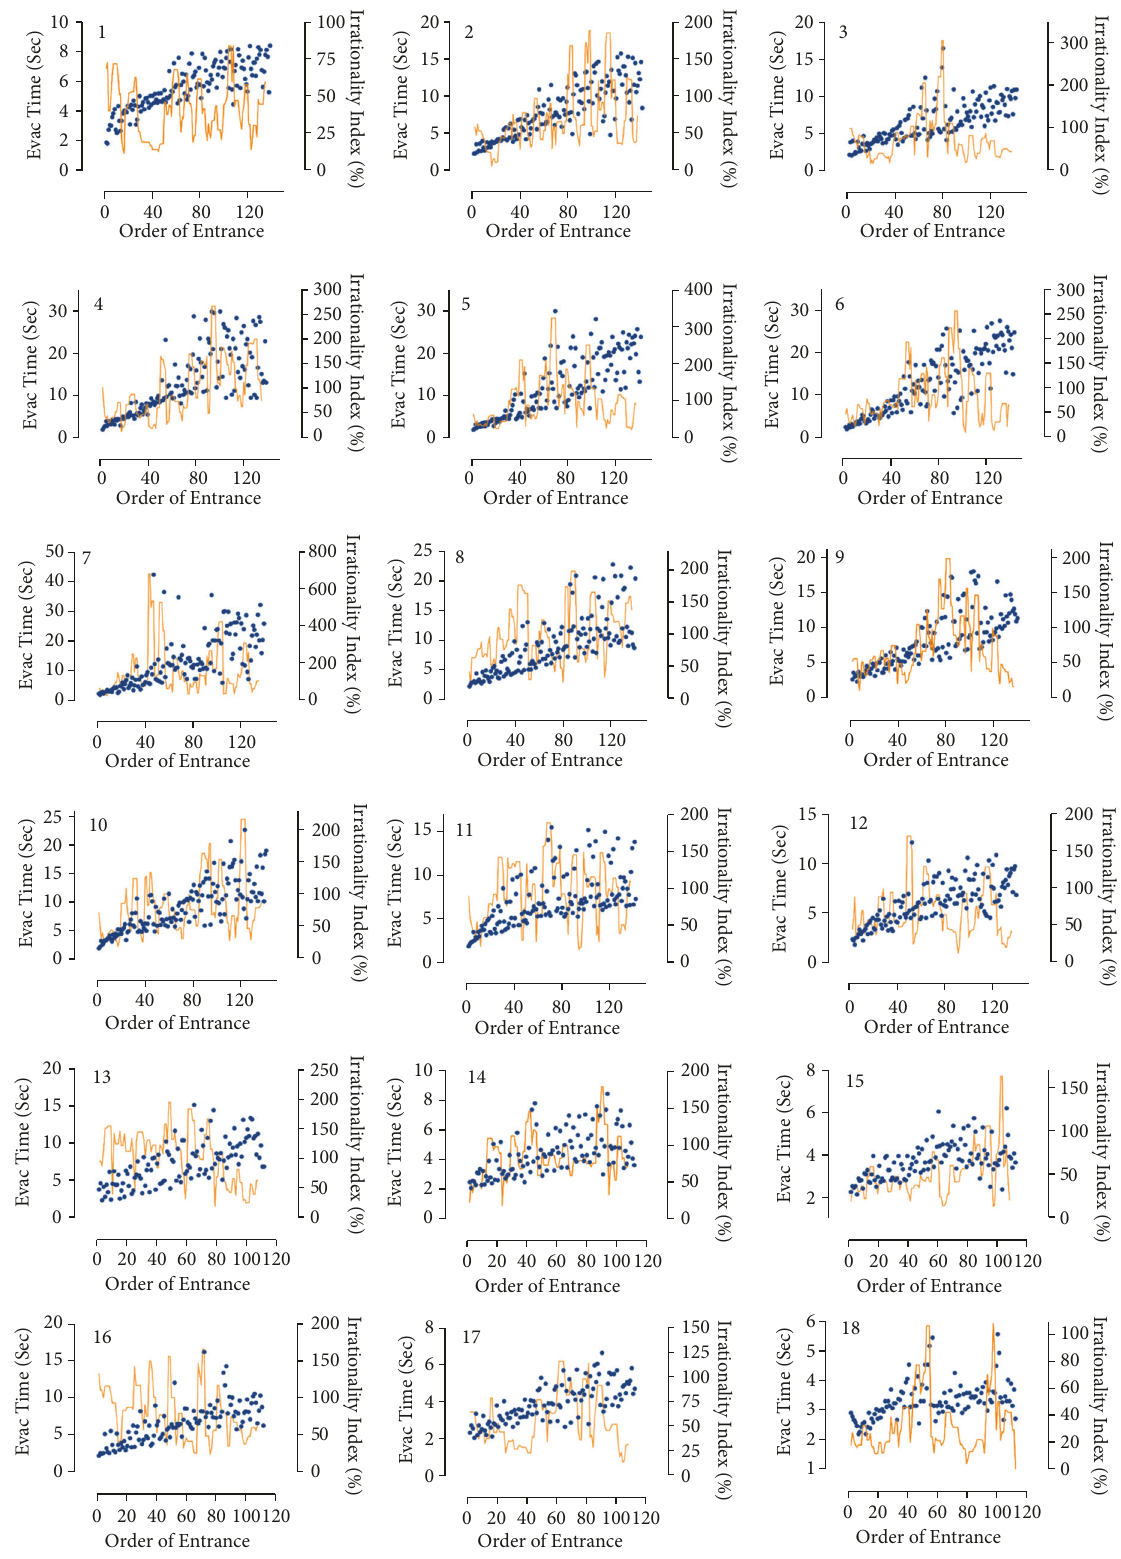
Figure 3: Scatterplots of the individual evacuation times for all 18 experimental scenarios, along with the “irrationality index” visualised at each point in time, shown by the orange fluctuating lines and represented by the right vertical axes of each